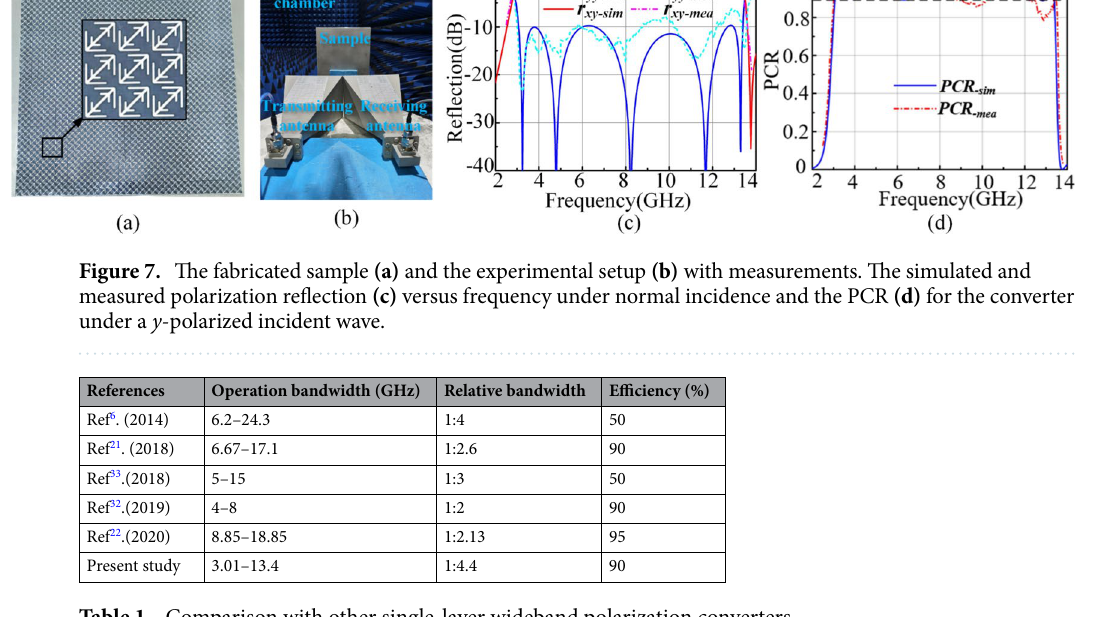
Table 1. Comparison with other single-layer wideband polarization